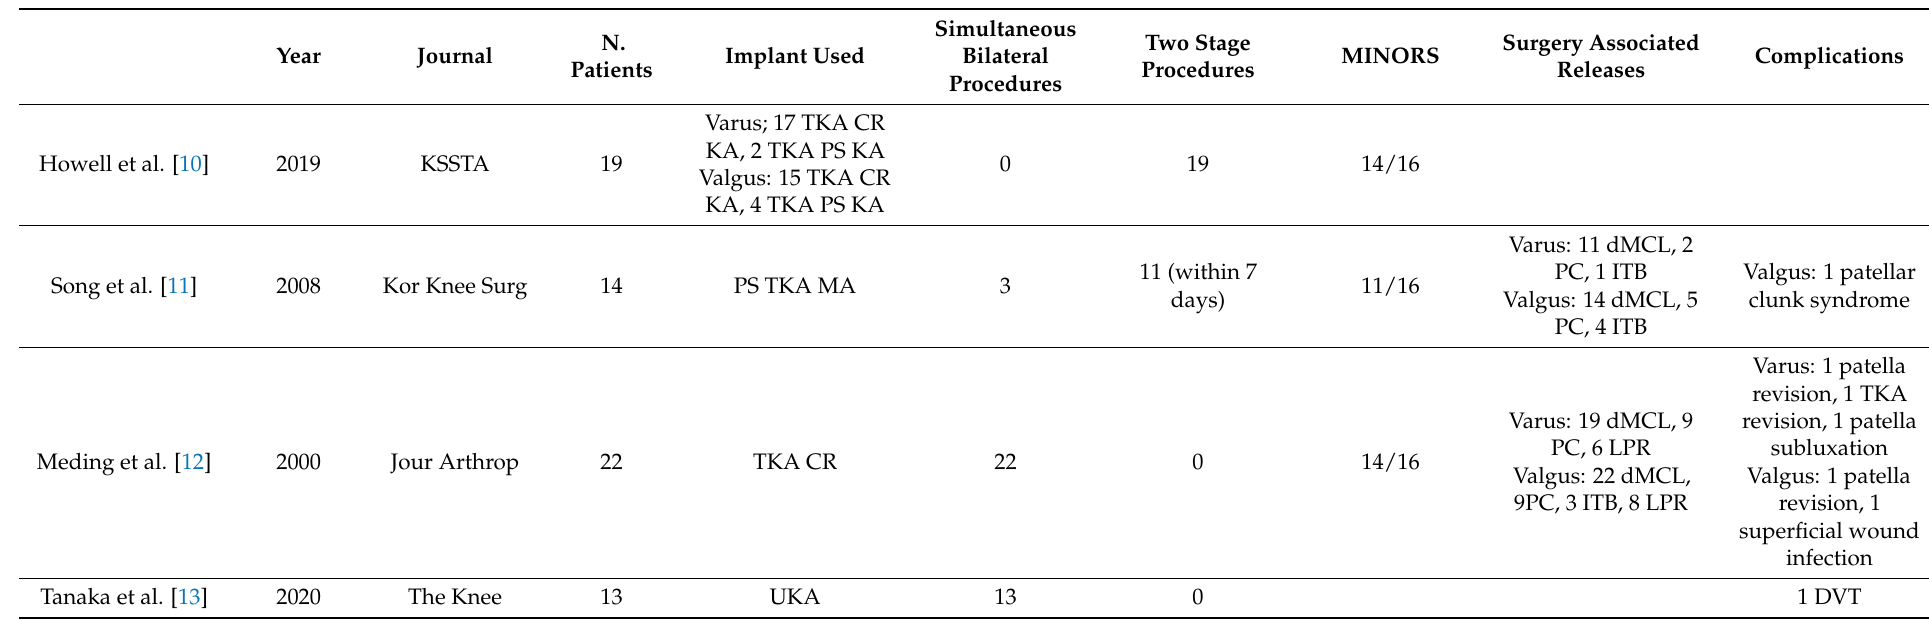
Table 2. TKA: Total Knee Arthroplasty; CR: Cruciate Retaining; PS: Posterior Stabilized; MA: Mechanical Aligned; KA: Kinematic Aligned; DVT: Deep